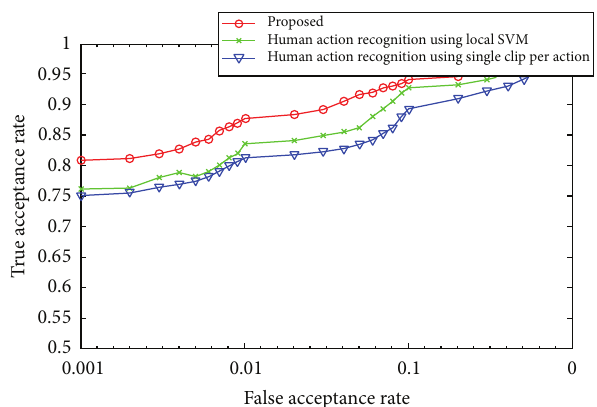
Figure 10: An ROC analysis for the proposed and other competitive techniques using all the frames of video.